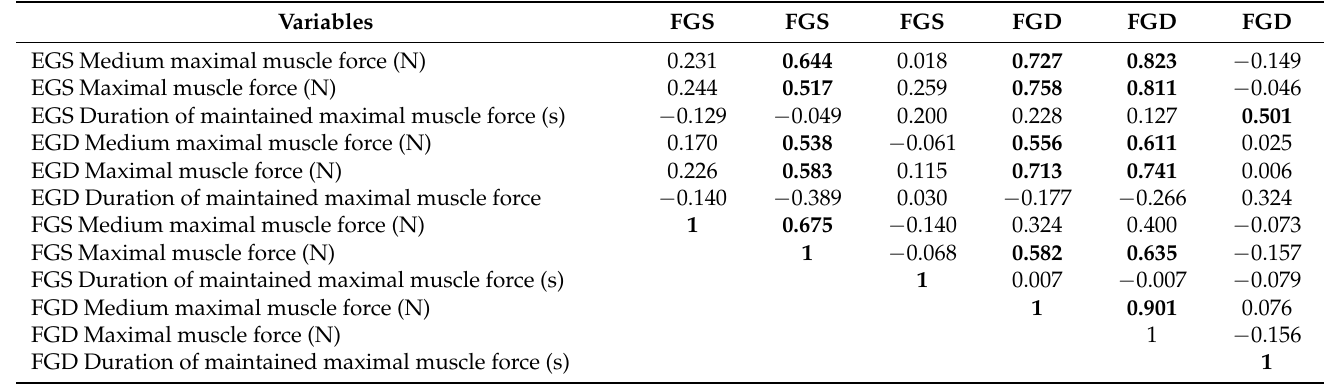
Table 16. Pearson correlation between muscle parameters of left and right knee extensors and flexors.